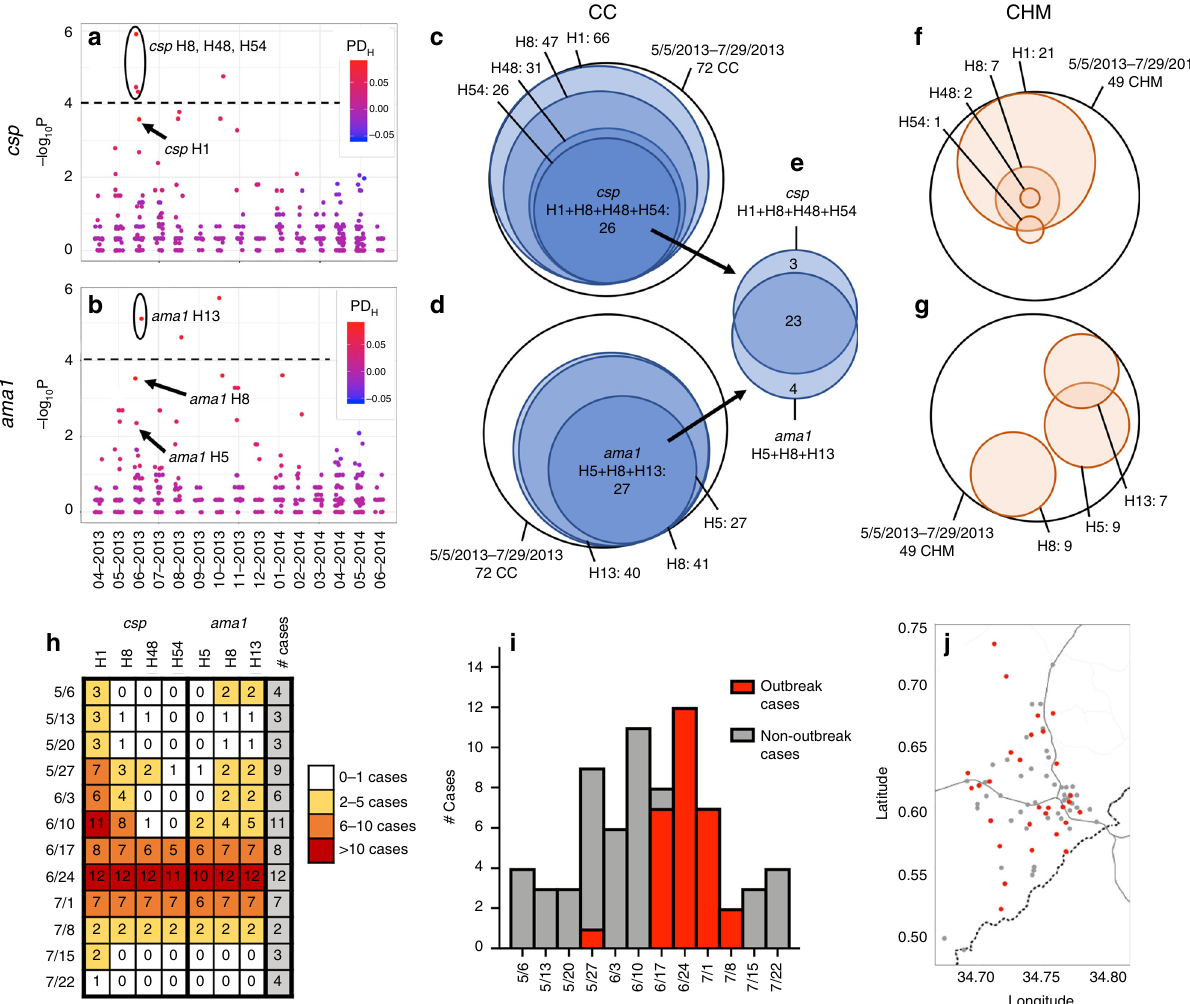
Fig. 6 Discovery of unique haplotype combination in case children indicating malaria outbreak. a , b The haplotype prevalence difference (PD H ) between case children (CC) and case household members (CHM) during each month was calculated for csp ( a ) and ama1 ( b ). Color indicates PD H , with red identifying haplotypes more common in CC and blue more common in CHM. The y-axis indicates the Fisher ’ s Exact test – log 10 (p-value) for haplotype prevalence in CC vs. CHM, while the dotted line denotes the Bonferroni-corrected threshold for statistical signi fi cance. c – g Venn diagrams of csp and ama1 haplotypes with a high incidence in case children for 72 CC and 49 CHM between 5/6/2013 and 7/28/2013 (only CC with both csp and ama1 haplotypes included). c , f 26 CC had evidence of co-infection with csp haplotypes 1, 8, 48, and 54, compared to no CHM. d , g 27 CC had evidence of co-infection with ama1 haplotypes 5, 8, and 13, compared to no CHM. e 23 CC were infected with CSP haplotypes 1, 8, 48, and 54 in addition to ama1 5, 8, and 13. h Number of CC each week from 5/6/2013 – 7/29/2013 infected with each haplotype associated with outbreak infection. White indicates 0 – 1 CC, yellow 2 – 5 CC, orange 6 – 10 CC, and red > 10 CC infected with a given haplotype in a particular week. i Outbreak epidemiology curve. Weekly case incidence from 5/6/ 2013 – 7/28/2013 is shown by overall bar height. Weekly incidence of outbreak cases (de fi ned as presence of > = 5/7 outbreak haplotypes CSP H1/H8/ H48/H54 and AMA H5/H8/H13, with these haplotypes comprising >98% reads detected) is indicated in red, and non-outbreak cases in gray. j Household location of case children (5/6/2013 – 7/28/2013) with outbreak cases (red) and non-outbreak cases